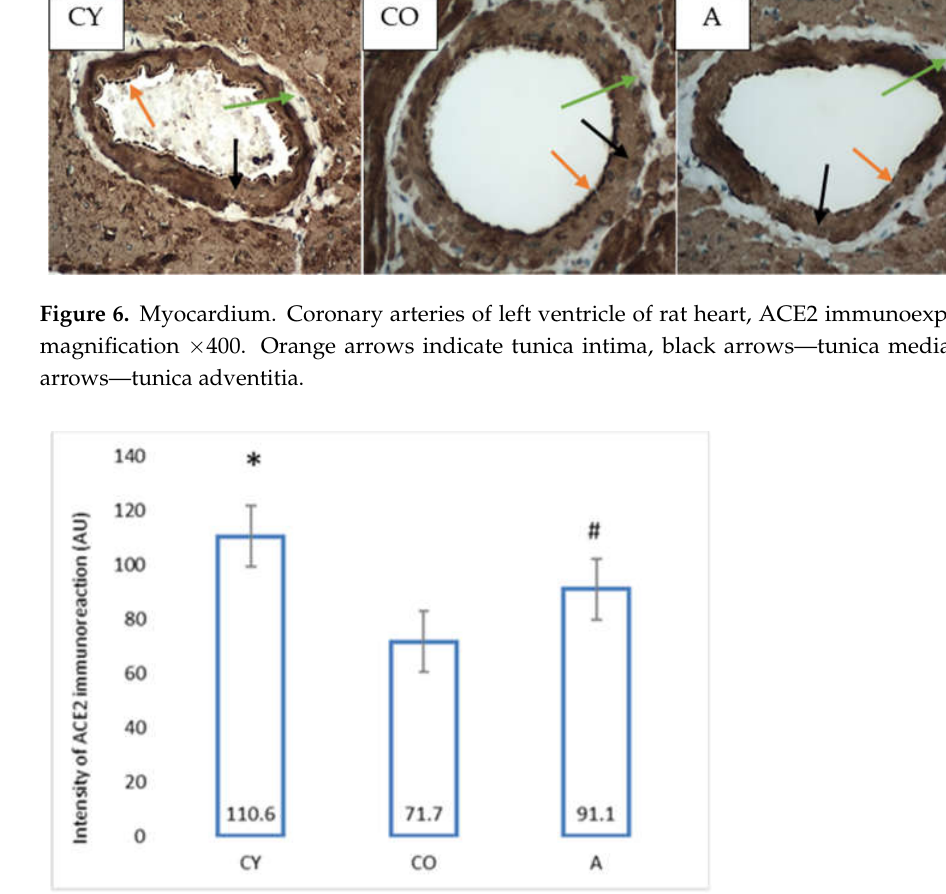
Figure 7. Intensity of ACE2 immunoreaction (in arbitrary units) in tunica media of coronary arteries of rat heart. * CO vs. CY, p < 0.05, # A vs. CO, p < 0.05 .